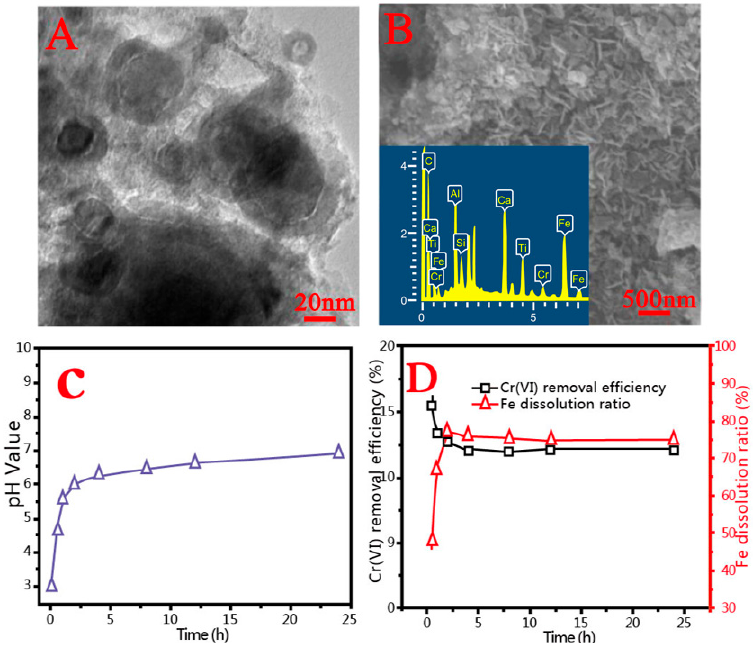
Figure 3. TEM ( A ) and SEM-EDS ( B ) images of the spent RM/carbon sample; pH and time during the removal process of Cr 6+ over RM/carbon at the initial pH of 3.0 ( C ); and removal efficiency of Cr 6+ and dissolution rate of Fe over RM / carbon at the constant pH of 3.0 ( D ) [40,44]. Reproduced with permission from [40], published by Elsevier B.V.,